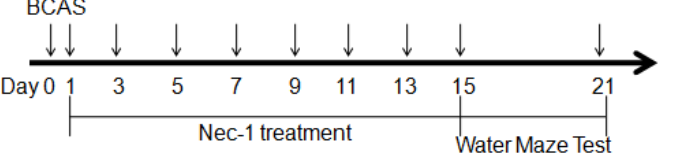
Figure 1. The diagram of the experimental design. Mice underwent surgery for BCAS at day 0 and were treated with Nec ‐ 1 every other day after surgery until the 15th day.